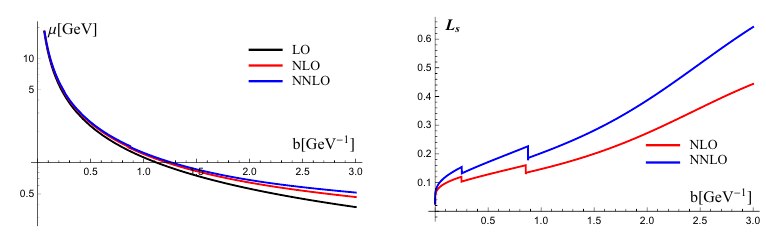
Figure 4 . (left) Value of (cid:22) saddle determined by (2.27) at di(cid:11)erent perturbative orders of D . (right) The value of L s at di(cid:11)erent perturbative orders of D . The LO value of L s is exactly zero, and thus is not shown. The kinks are produced by the change on number of active quarks N f and quark